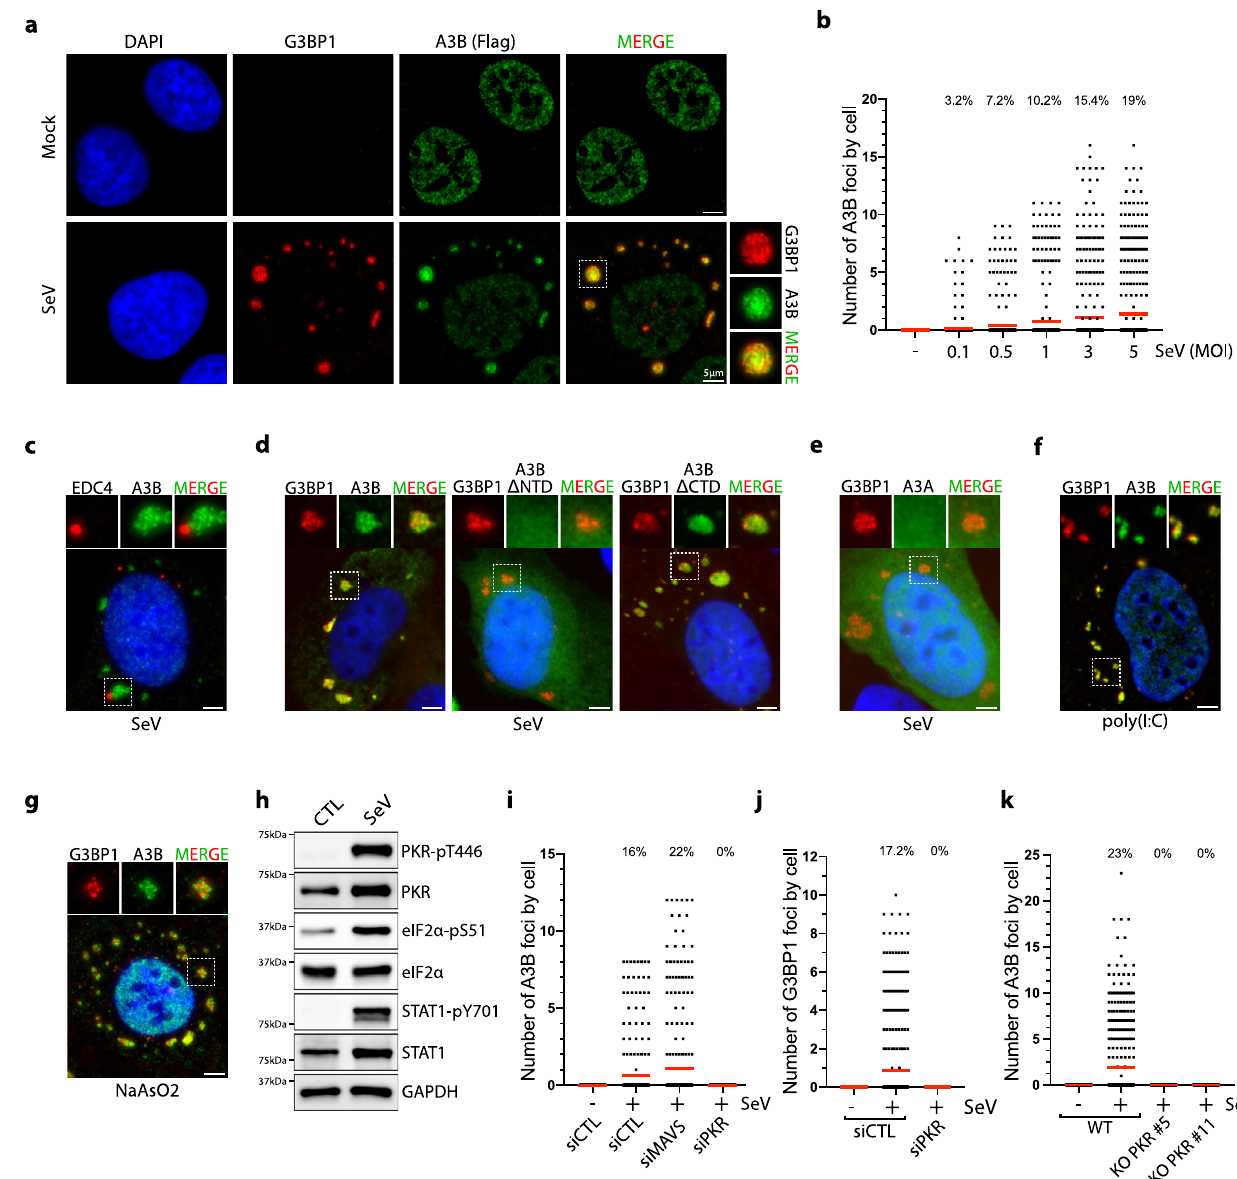
Fig.1|SeVinfectioninducesAPOBEC3Blocalizationtostressgranules.a U2OS- A3B- fl agcellstreatedwithDOXwereinfectedwithSeV(MOI=1,24hpi)andA3Band G3BP1 localization were monitored with a fl ag and a G3BP1 antibody respectively. Scale bar: 5 μ m. b Quanti fi cation of the number of cytoplasmic A3B foci by cell in individualcells infectedwith SeV attheindicated MOI for24h. Top; percentage of cells with A3B foci. Red lines indicate the mean. (Number of cells, n =500) c Immuno fl uorescenceforA3B(Flag)andEDC4inU2OS-A3B- fl agcellstreatedwith DOX and infected with SeV (MOI=1, 24hpi). Scale bar: 5 μ m. d U2OS cells were transfected with the indicated GFP tagged A3B constructs and subsequently infected with SeV (MOI=1). A3B localization to SGs was monitored 24hpi by immuno fl uorescence. Scale bar: 5 μ m. e The localization of A3A-GFP to SGs after SeV infection at MOI=1 was monitored by immuno fl uorescence at 24hpi with GFP and G3BP1 antibodies respectively. Scale bar: 5 μ m. Immuno fl uorescence for A3B